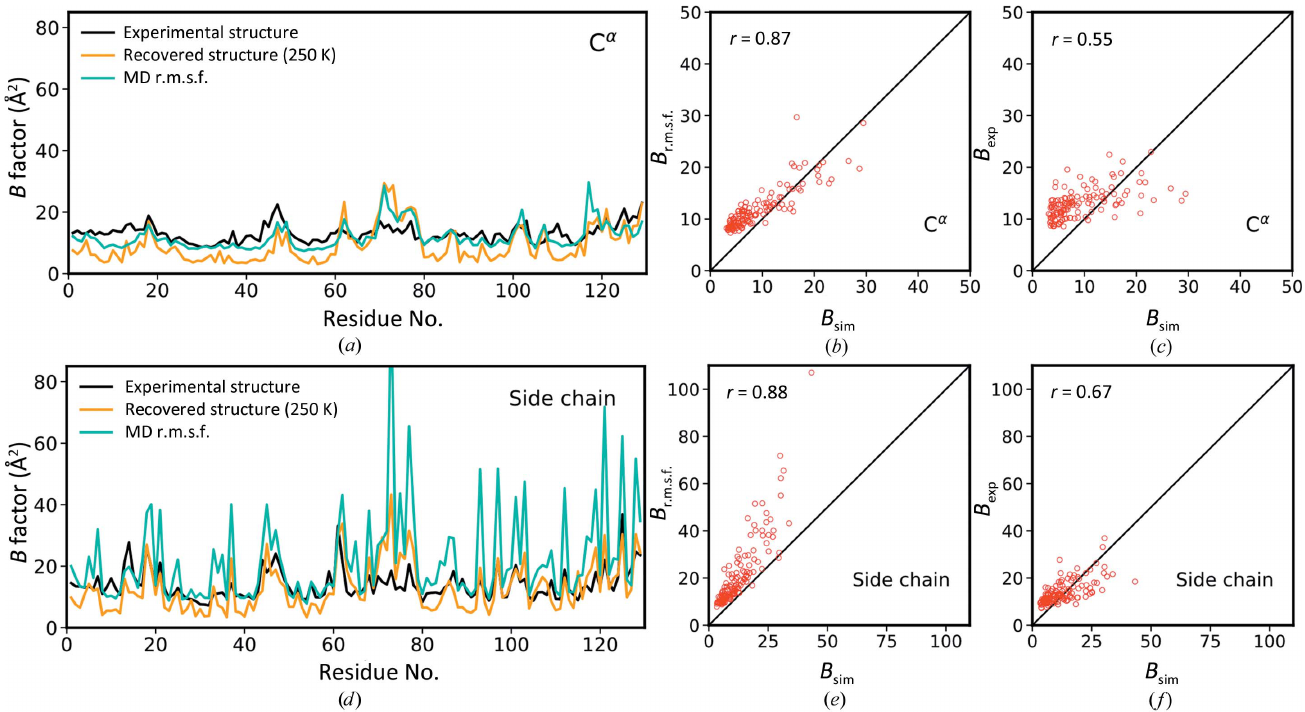
Figure 3 Crystalline dynamics as reflected in the B factors using the simulations at 250 K. ( a ) B factors of C (cid:5) atoms as found in our experimental lysozyme structure ( B exp , black profile) and recovered lysozyme structure ( B sim , orange profile), as well as calculated from the MD trajectories using equation (3) ( B r.m.s.f. , cyan profile). ( b , c ) Correlation plots B r.m.s.f. versus B sim and B exp versus B sim for C (cid:5) atoms. ( d ) Mean side-chain B factors B exp , B sim and B r.m.s.f. plotted as a function of residue number. ( e , f ) Correlation plots B r.m.s.f. versus B sim and B exp versus B sim for mean side-chain B factors. The calculations of B r.m.s.f. used the same set of ten MD frames that was used to simulate diffraction photographs. The analogous results from 298 K simulations are shown in Supplementary Fig.